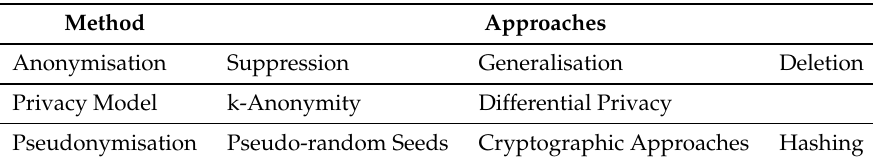
Table 4. Overview of selected approaches for privacy-preserving processing from the literature separated into anonymization, privacy models and pseudonymization.